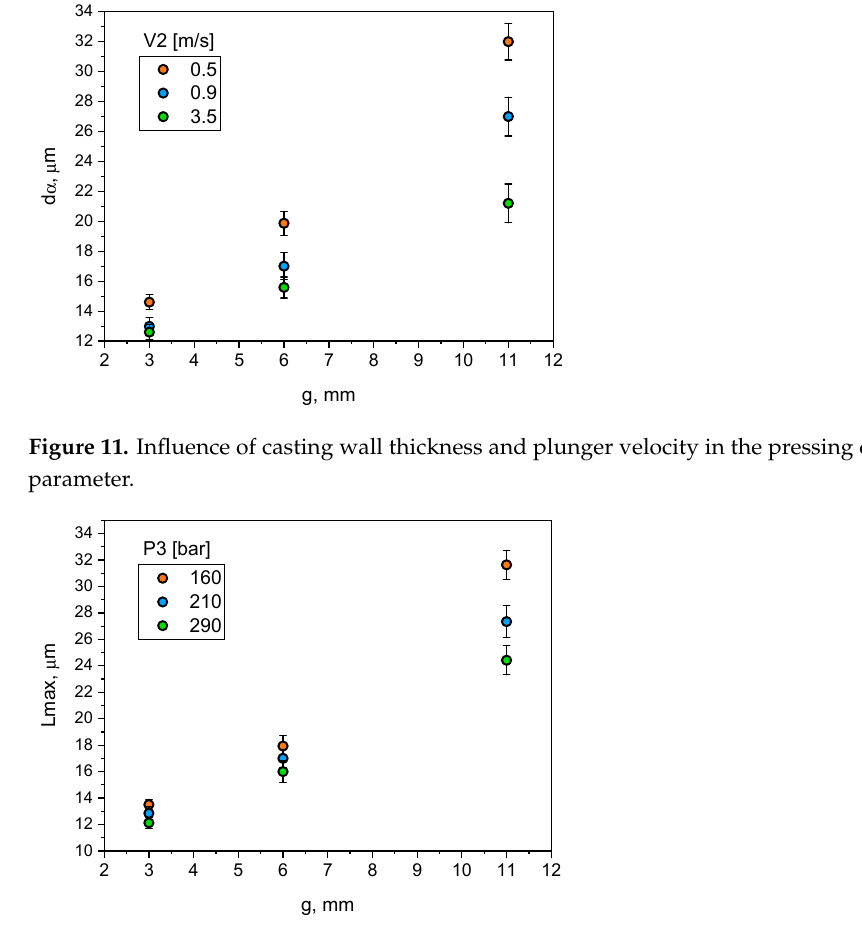
Figure 12. Influence of casting wall thickness and compression pressure on L max parameter.